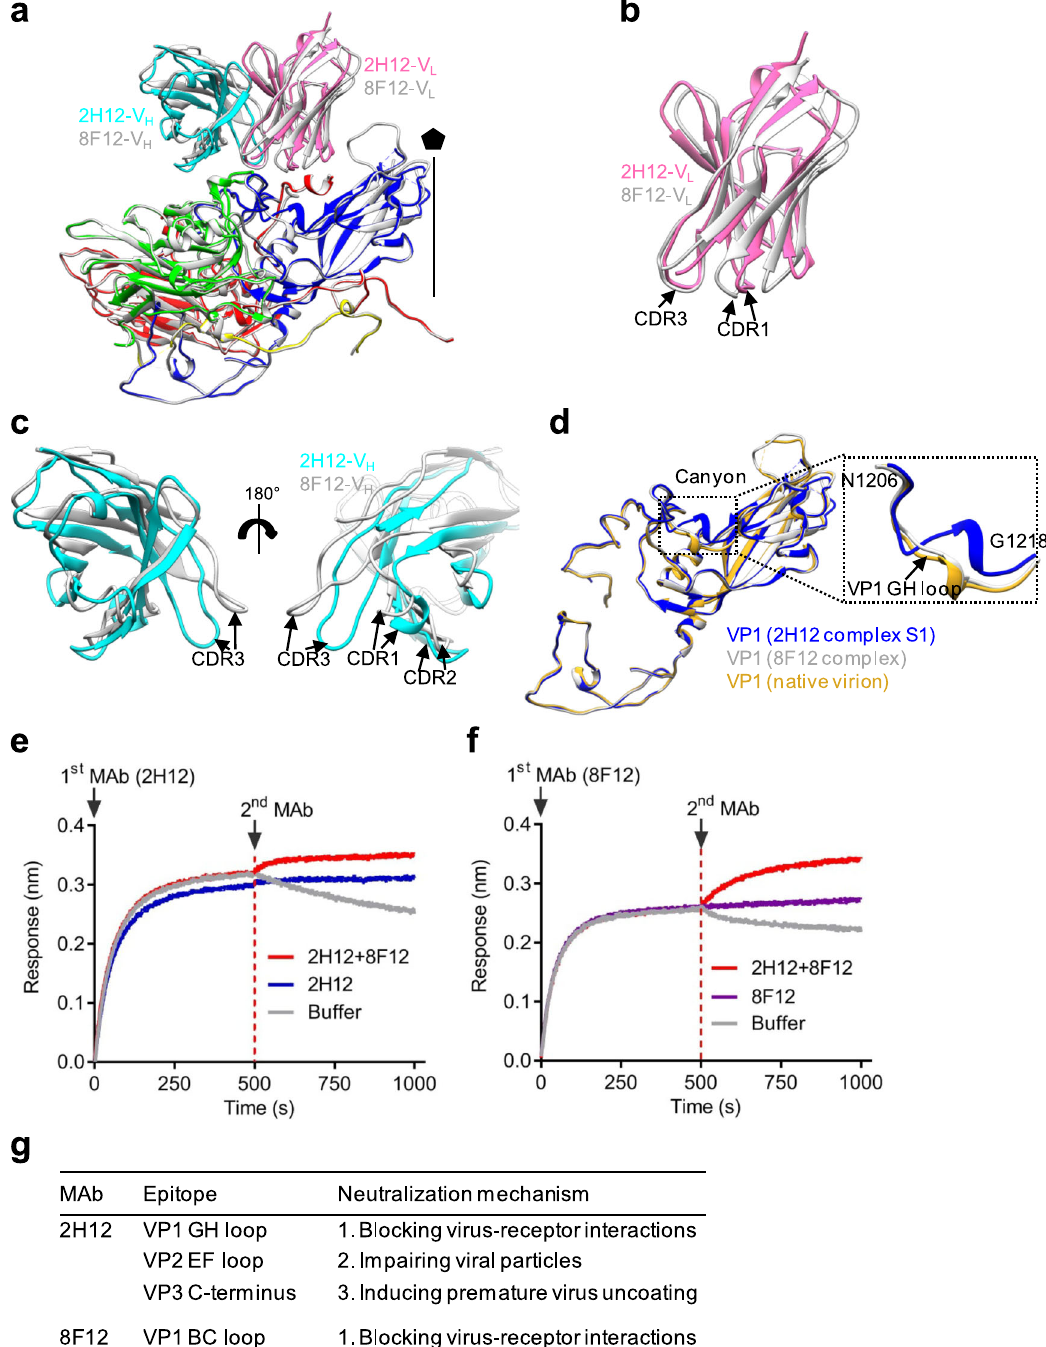
Fig. 6 Structural comparison of the two immune complexes. a Superposition of EV-D68/2H12 (state S1; color) and EV-D68/8F12 (gray) protomer structures. b Enlarged view of superposition of 2H12-V L (hot pink) and 8F12-V L (gray) structures. c Enlarged view of superposition of 2H12-V H (cyan) and 8F12-V H (gray) structures. d Superposition of the VP1 structures from EV-D68/2H12 (state S1; blue), EV-D68/8F12 (gray), and unbound native EV-D68 virion (PDB: 6CSG; goldenrod). The boxed area is enlarged to better illustrate the large movement of VP1 GH loop in EV-D68/2H12 (state S1). e , f Competitive binding assay using BLI. Immobilized EV-D68 virion (18947 strain) was saturated with the fi rst antibody 2H12 ( e ) or 8F12 ( f ) and then allowed to react with the buffer, the antibody mixture (2H12 + 8F12), 2H12 alone (control) ( e ) or 8F12 alone (control) ( f ). g Summary of the epitopes and neutralization mechanisms of the 2H12 and 8F12